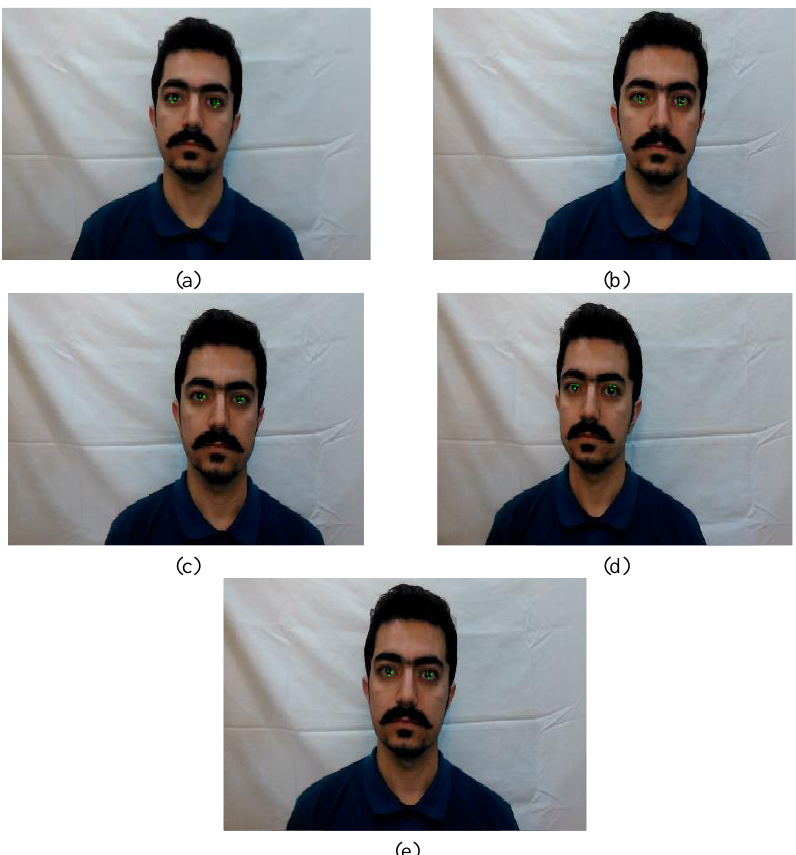
Figure 9. The results of eye tracking in the second scenario: a) frame 1; b) frame 50; c) frame 100; d) frame 150; c) frame